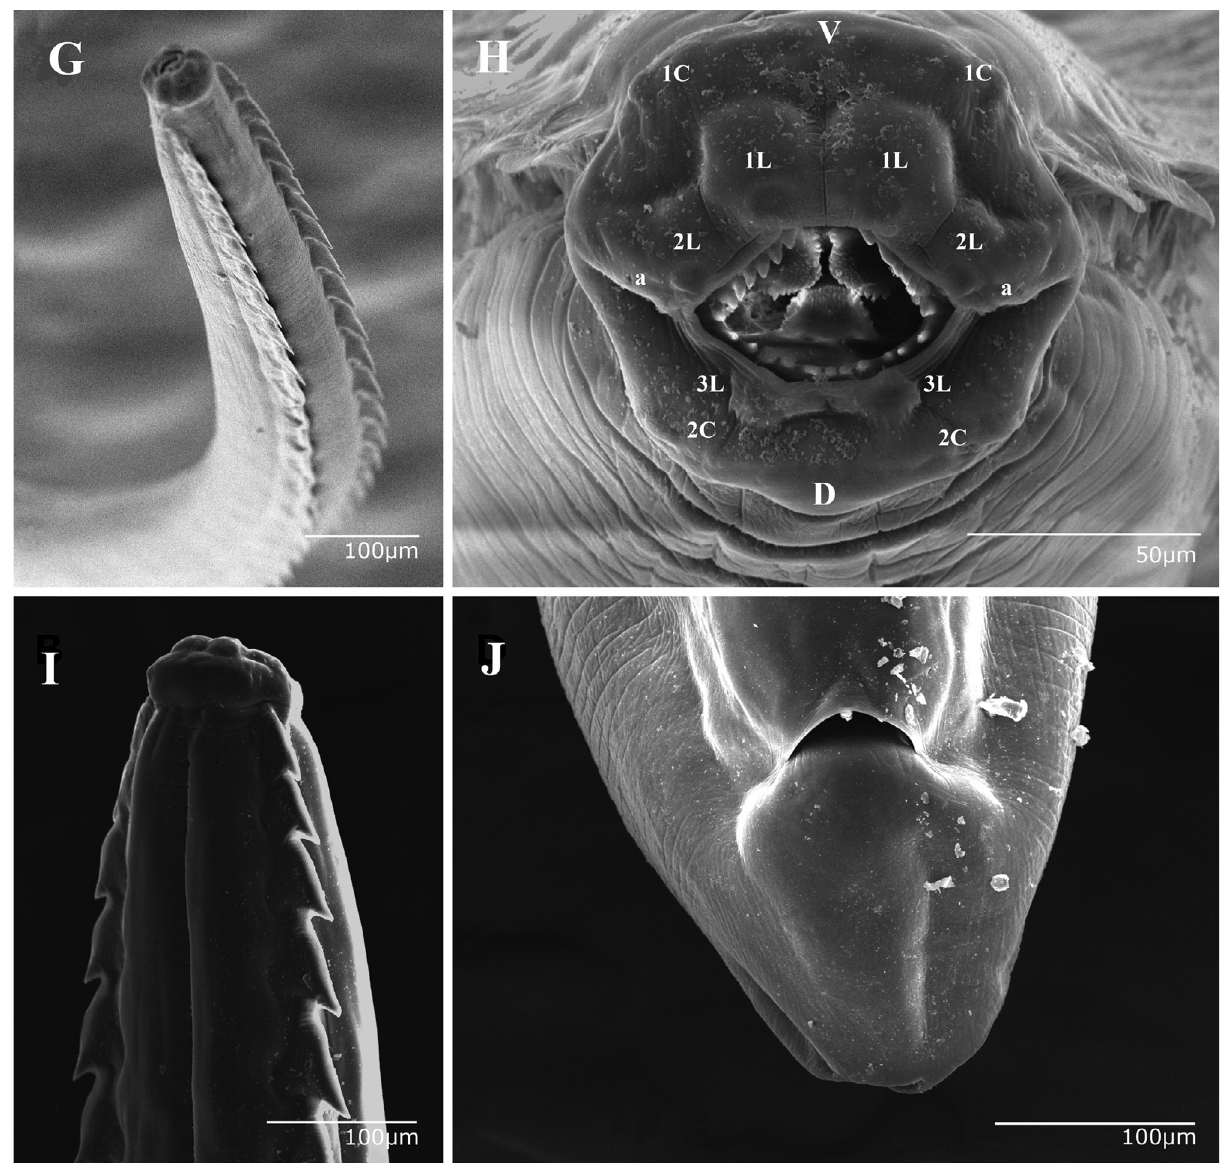
Figure 2. (G–J) Pterygodermatites ( Paucipectines ) baiomydis n. sp., a parasite of Baiomys taylori from Colima, Mexico. Scanning electron micrographs: G. Female, anterior end, subventral combs. H. Female, anterior end, apical view [Cephalic papillae: 1C . Pair 1. 2C . Pair 2. Labial papillae: 1Iv . Internal pair 1 (ventral). 2Ilv . Internal pair 2 (lateroventral). 3Ild . Internal pair 3 (dorsal). a . Amphid. V. Ventral region. D. Dorsal region]. I. Female, anterior end, ventral view. J. Female, posterior end, ventral